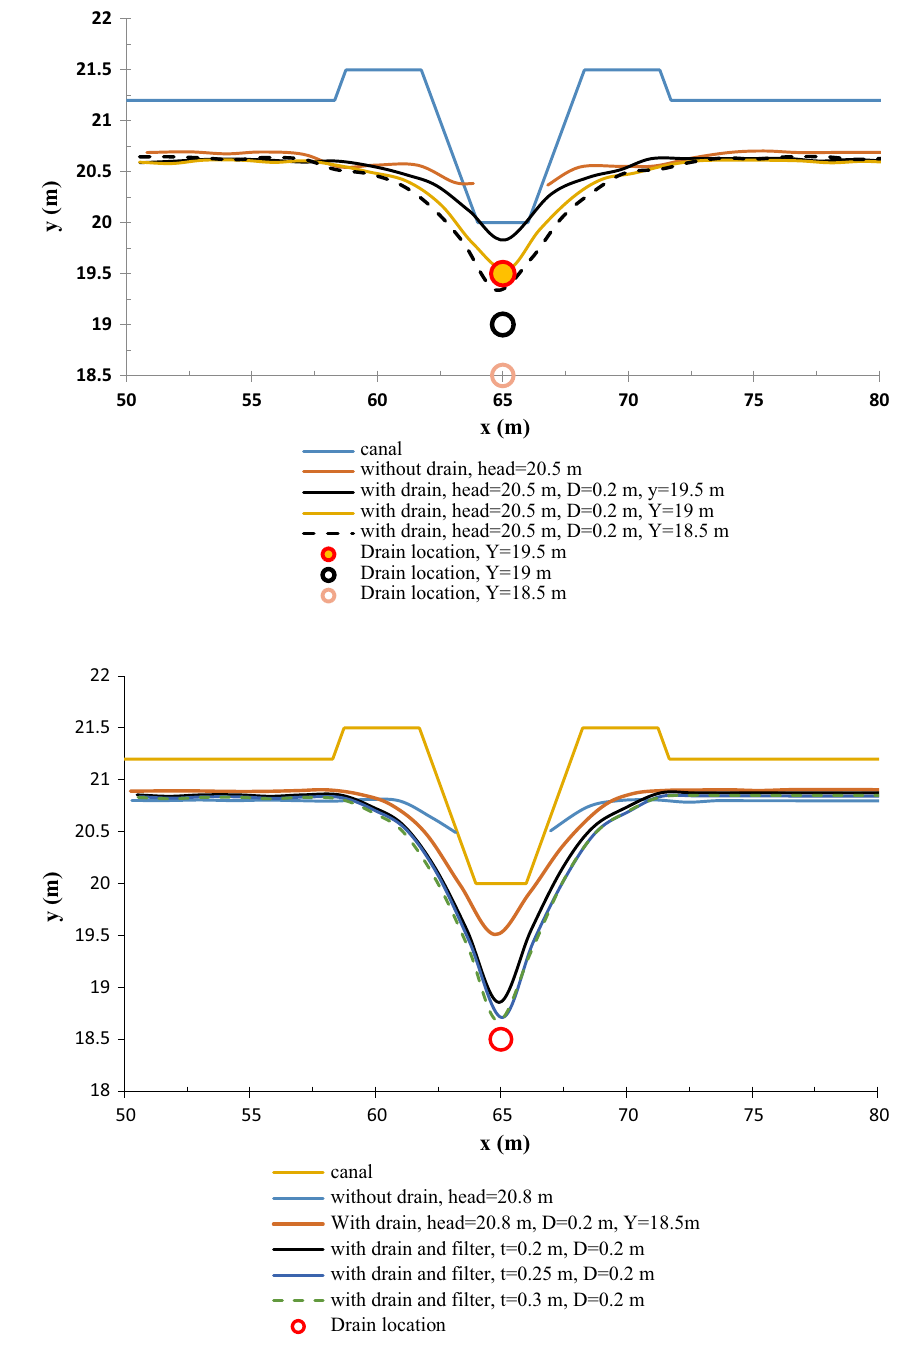
Fig. 7 Phreatic lines for dif- ferent drain depths from the canal bed with H = 20.5 m and D = 0.2 m